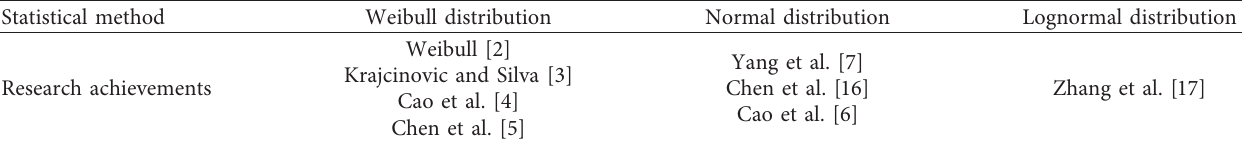
Table 1: Phenomenological statistical damage